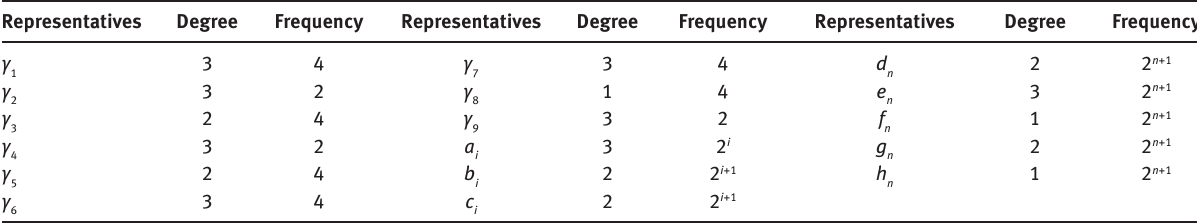
Table 6: Representatives with their degrees and frequencies of occurrence for n ≥ 1.